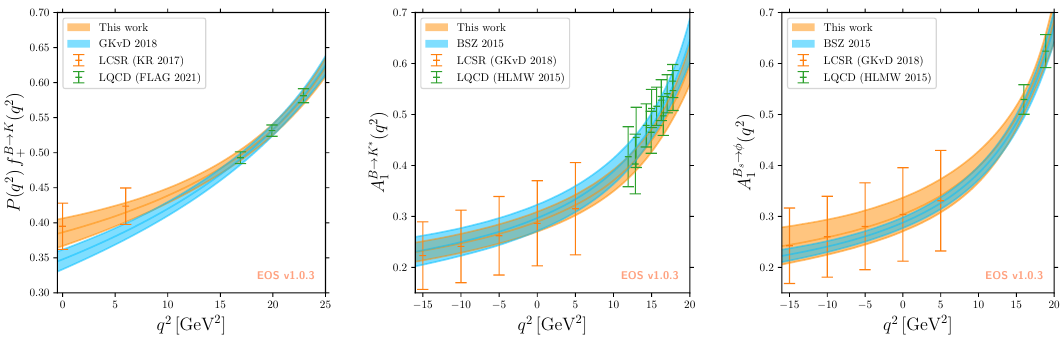
Figure 1 . Plots of a selection of the local B → M FFs discussed in this work. Our results (in orange) are juxtaposed with those of ref. [30] for B → K and ref. [29] for B → K ∗ and B (both in blue). We show the medians as solid lines and the central 68% uncertainty interval as shaded areas. For the B → K process, we show the product of the FF f B → K and in the literature and the basis used in this work is presented in appendix